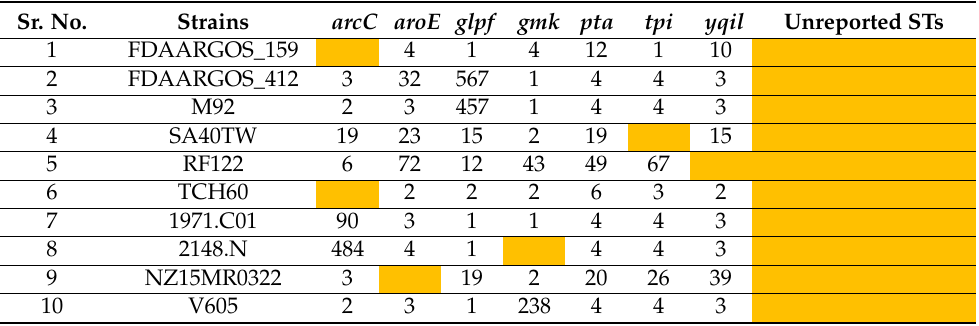
Table 2. Unreported alleles and STs. The table represents unreported allelic profiles (STs) in the reported scheme. The orange color highlights the unreported alleles and STs in 502 genomes. Sr.